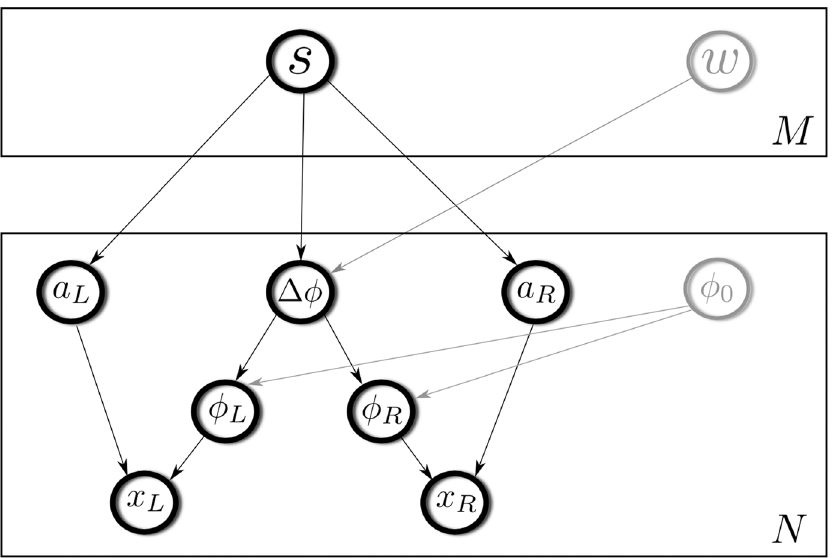
Fig 1. The graphical model representing variable dependencies. The lowest layer represents sound epochs perceived by the left and the right ear x L and x R . They are decomposed by a sparse coding algorithm into phase and amplitude vectors ϕ L , ϕ R and a L , a R . Phases are further substracted from each other in order to obtain an IPD vector Δ ϕ . The second layer encodes jointly monaural amplitudes and IPDs. Auxiliary variables (phase offset and the scaling factor w ) are depicted in